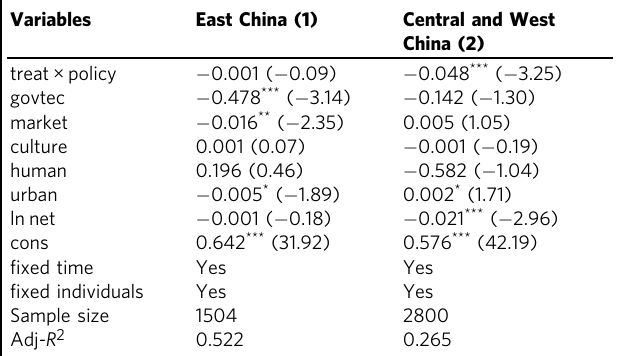
Table 8 Regression result of regional